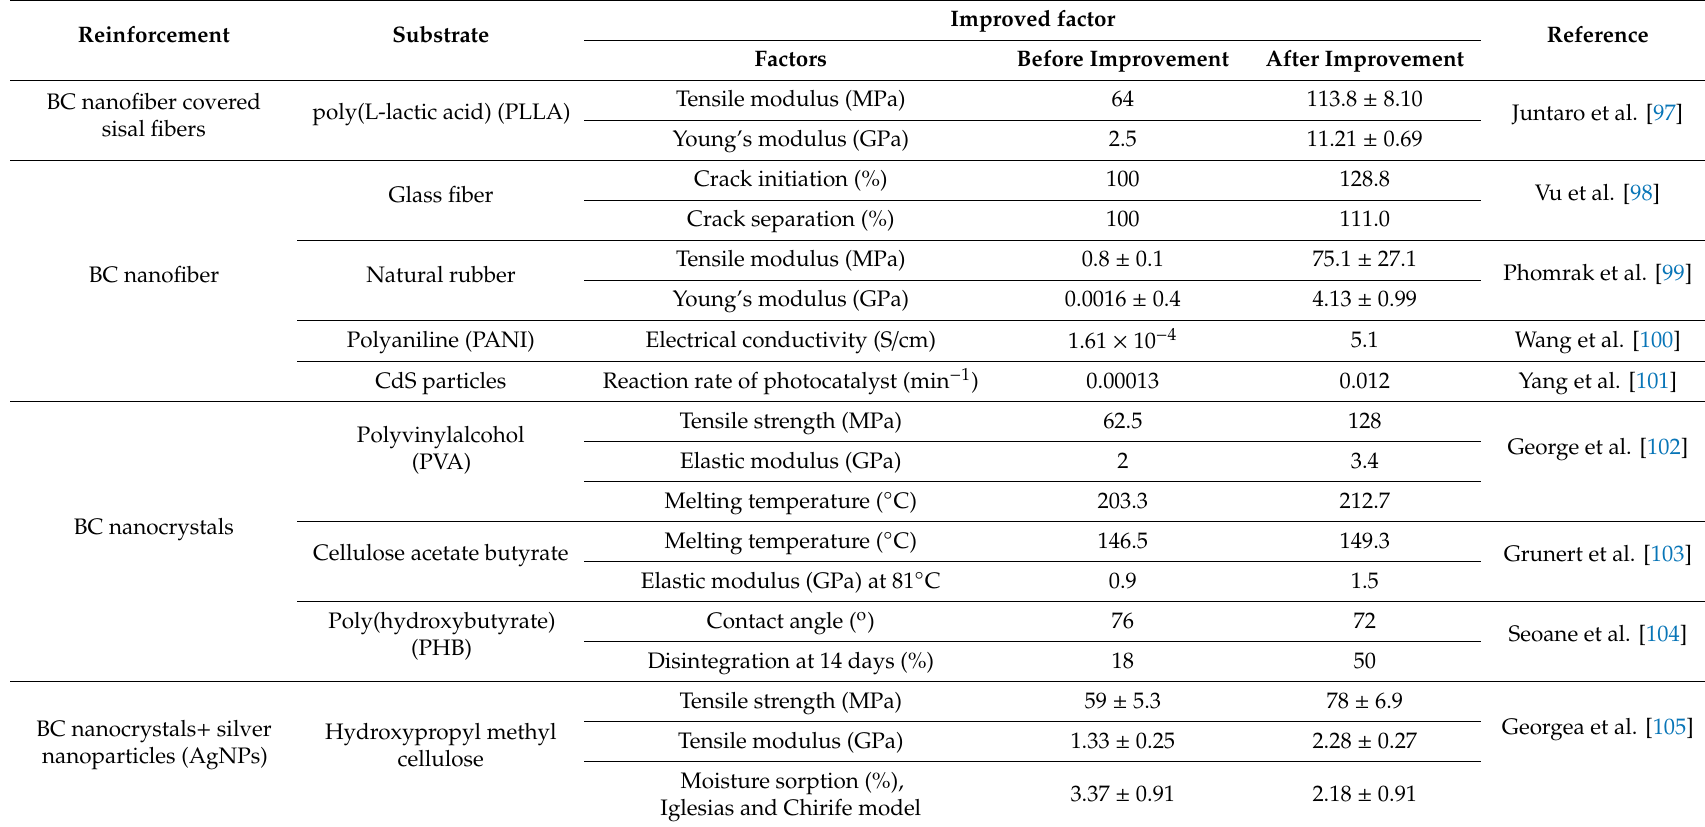
Table 4. Improved mechanical properties of nanocomposites reinforced with bacterial cellulose (BC) nanofibers and